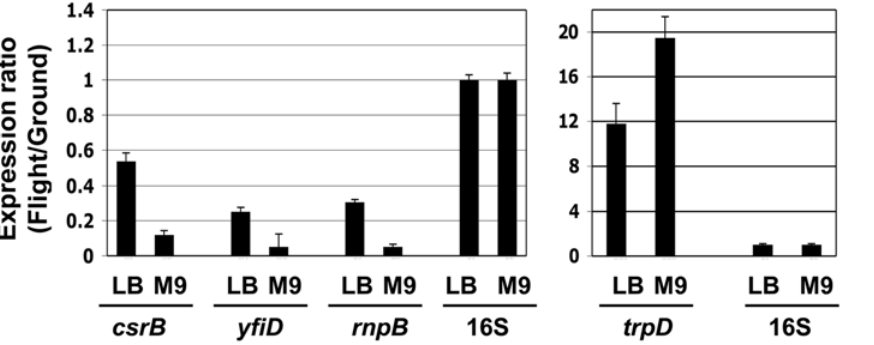
Figure 2. qRT-PCR analysis confirms S.typhimurium gene expression altered during spaceflight in LB and M9 media. Total RNA harvested from spaceflight and ground cultures in the indicated media was converted to single-stranded cDNA and used as a template in qRT-PCR analysis with primers hybridizing to the indicated genes. PCR product levels were normalized to the 16S rRNA product and a ratio of each gene level in flight and ground cultures was calculated. All differences in expression between spaceflight and ground cultures were found to be statistically significant using student’s t-test (p-value , 0.05). The error bars represent the standard deviation for three to nine independent technical replicate